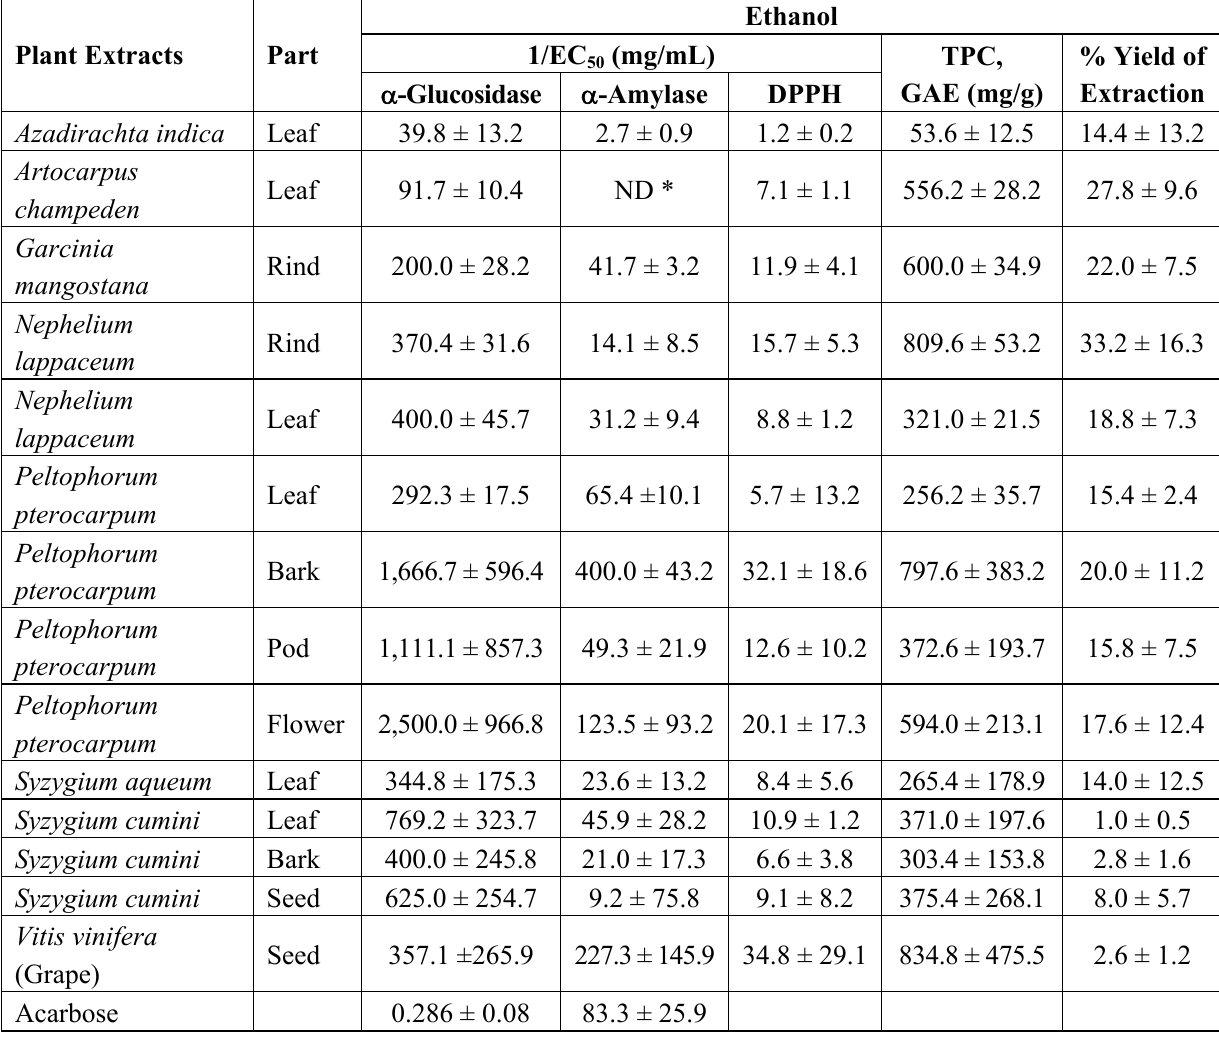
Table 2. 1/EC of  -glucosidase,  -amylase and DPPH activity, TPC and yield of ethanolic 50 extraction of various plant